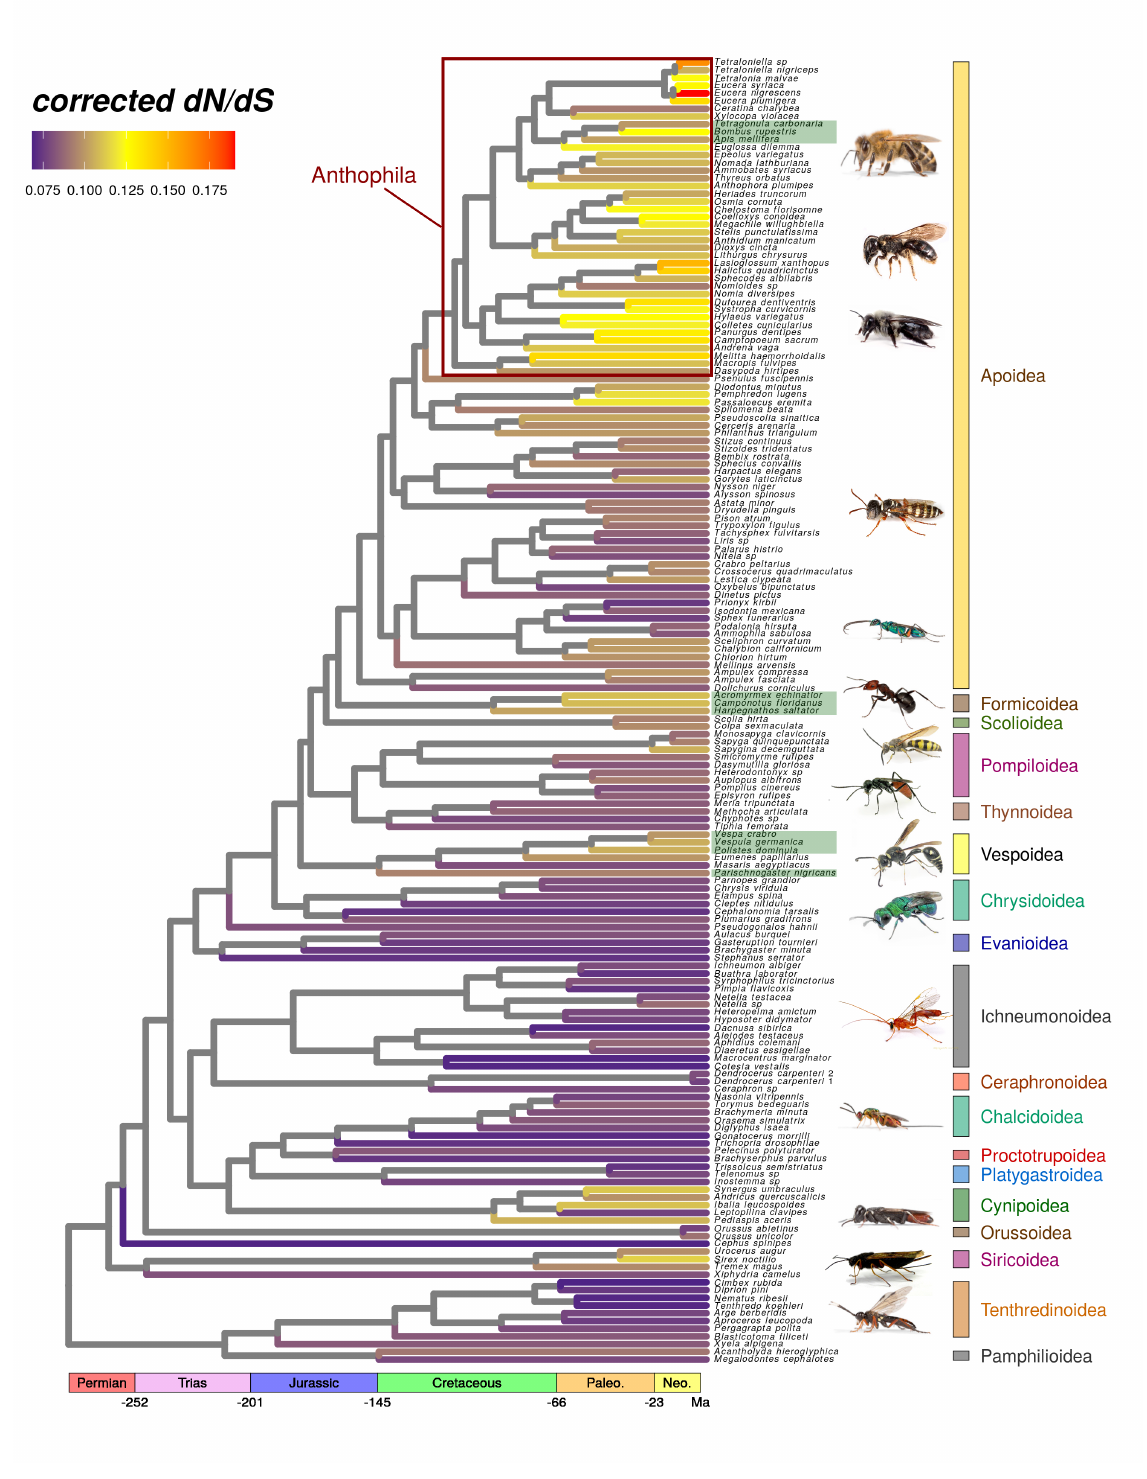
Figure 1 – Corrected genomic dN/dS ratios for 169 species of Hymenoptera. dN/dS ratios estimated on terminal branches using 3241 genes are represented on the chrono- gram inferred by Peters et al. (2017). Green rectangles around labels indicate eusocial